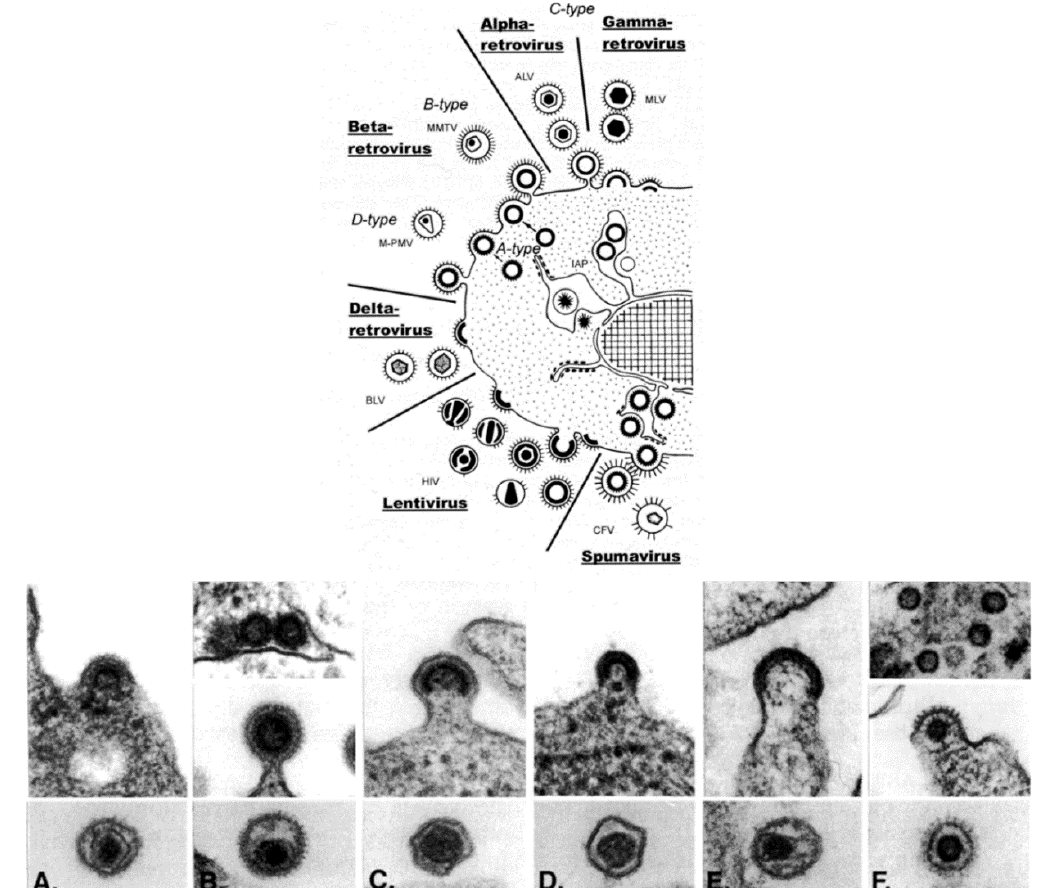
Figure 3. ( Top ) schematic diagram of the morphogenesis of the members of the family Retroviridae ; ( Bottom ) budding profiles and mature virions. ( A ) Avian leukosis virus (genus Alpharetrovirus ); ( B ) Mouse mammary tumor virus (genus Betaretrovirus ); ( C ) Murine leukemia virus (genus Gammaretrovirus ); ( D ) Bovine leukemia virus ( Deltaretrovirus ); ( E ) Human immunodeficiency virus 1 (genus Lentivirus ); ( F ) Simian foamy virus (genus Spumavirus ). (Top, reproduced with permission from Reference [14]. Copyright 2002 Kluwer Academic/Plenum Publishers. Bottom, reproduced with permission from Reference